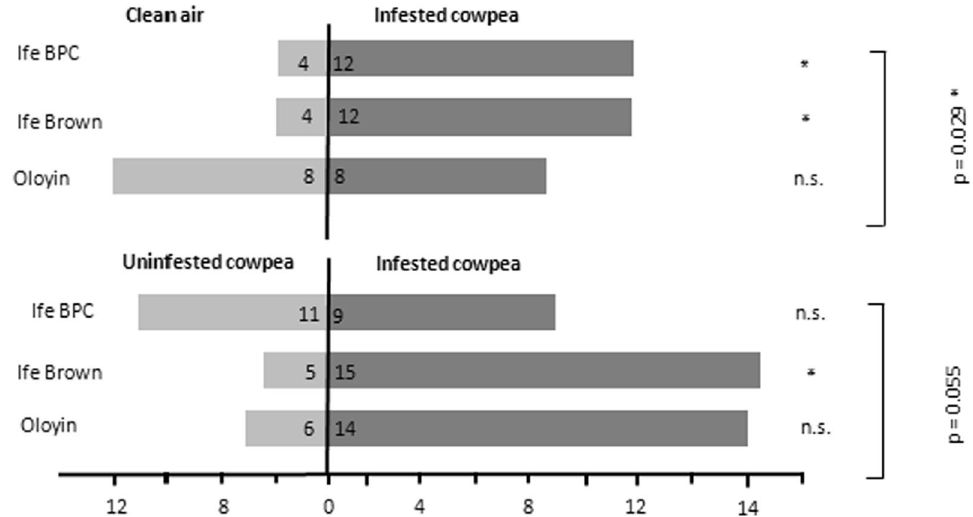
Fig. 1 Attraction behavior of Dinarmus basalis to odors from infested cowpea, clean air and uninfested cowpea. * different; ns means are not significantly different; p -value greater than 0.05 shows that means are not significantly =